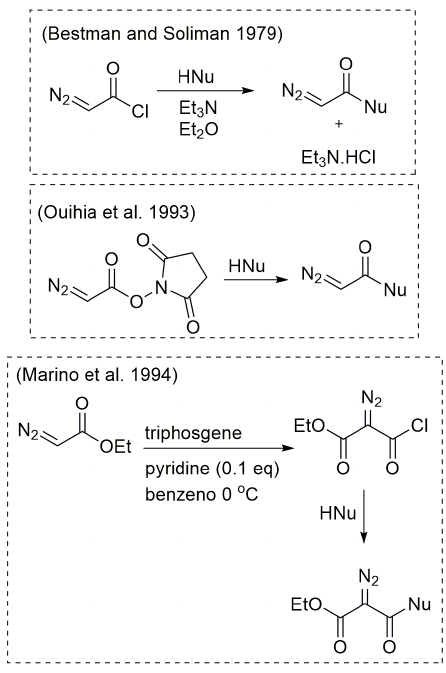
Figure 55 - Diazoacetylation reaction with diazocarbonyl compounds.